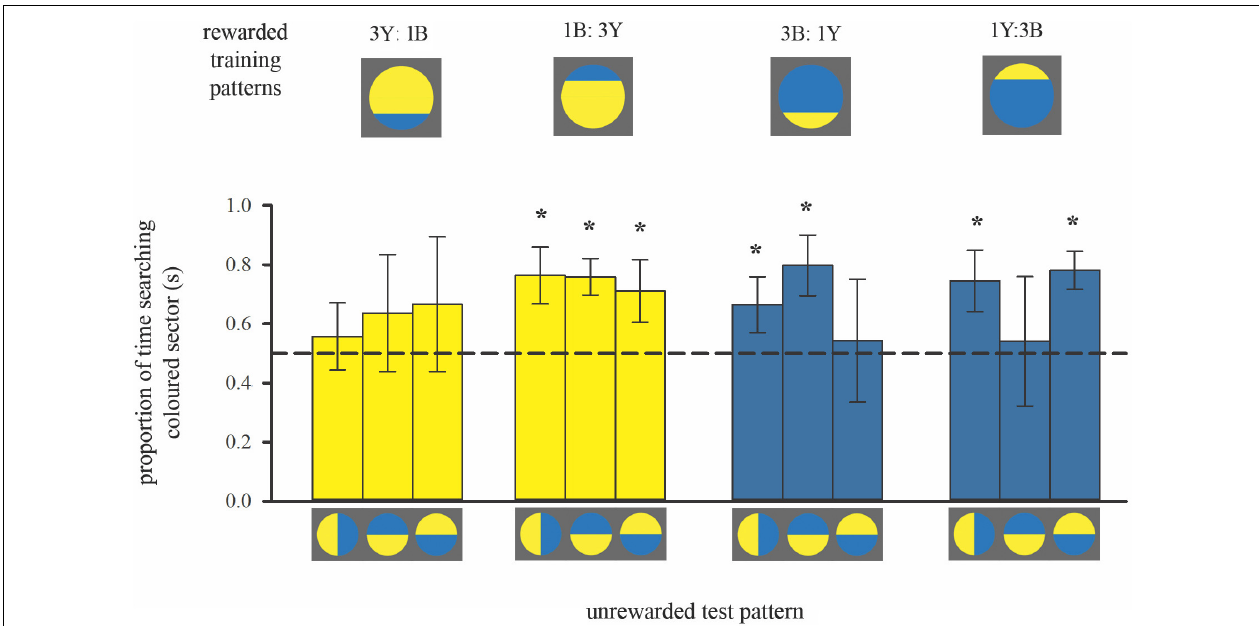
FIGURE 4 | Colour preferences of bees trained with bicolour patterns with unequal segments (3:1 diameter ratio) in subsequent unrewarded tests. As in Figure 2 , the search time is shown when the bees flew in front of the unrewarded pattern displaying search behaviour, within the distance of 5 cm from the target. Bars represent the mean proportion of time spent searching on the test pattern segment that displayed the same colour as the larger segment of the training stimulus (also depicted by bar colour) relative to the search on the other segment, in each of the three tests. For sample sizes see Figure 3 . Error bars represent ± 1 standard deviation. Asterisks * above bars denote a significant deviation from equal choice at α = 0.05 (Paired t -tests; see Supplementary Table 1